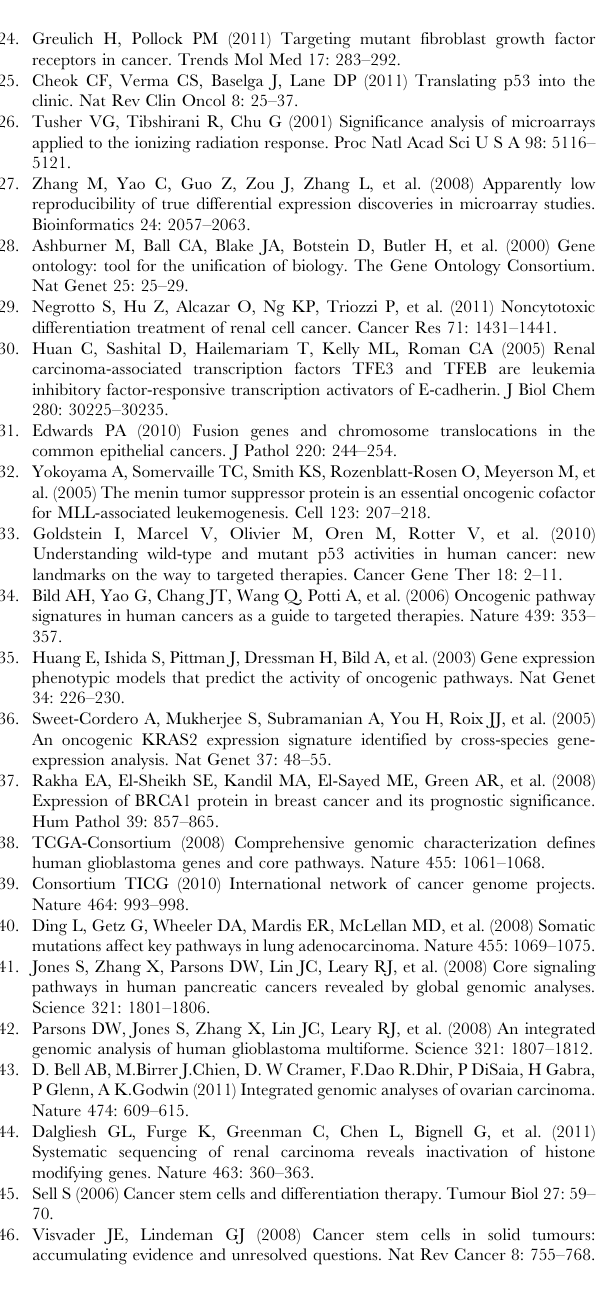
Table S4 All cancer genes with differential expression, methyl- ation or copy number changes in their corresponding cancer types. Table S5 Down-regulated or hypermethylated c-oncogenes involved in cell differentiation. Table S6 The comparison between the altered frequencies of C- oncogenes (C-TSGs) and the expected altered frequencies. Table S7 C-oncogenes, c-TSGs and stability c-TSGs for nine cancer types.